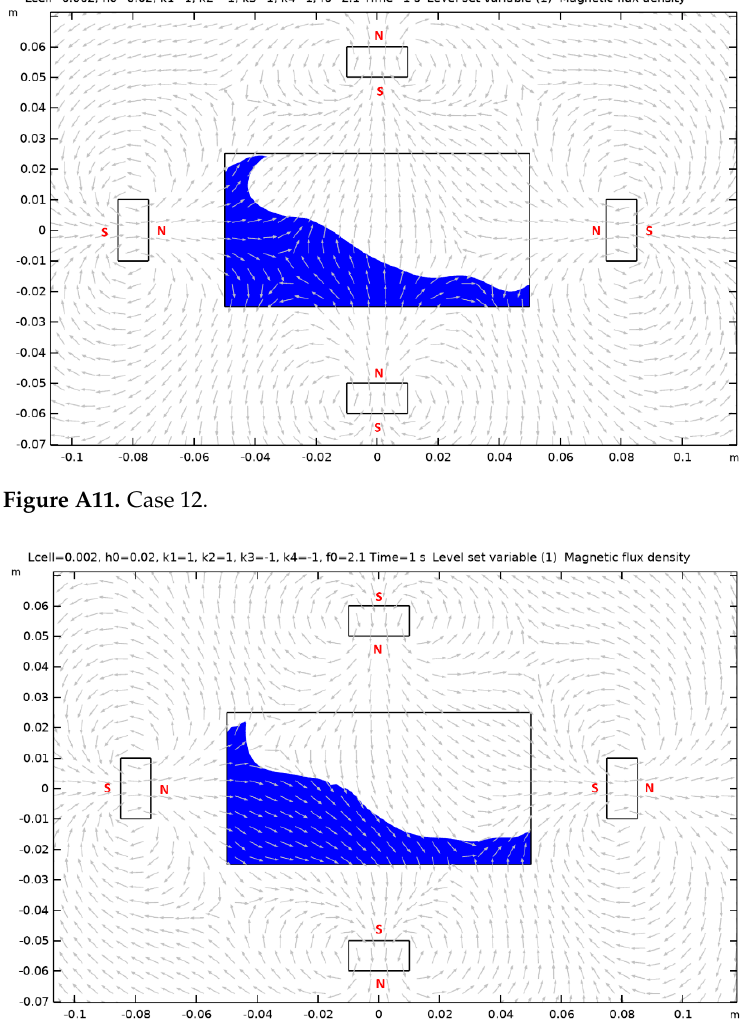
Figure A12. Case 13.